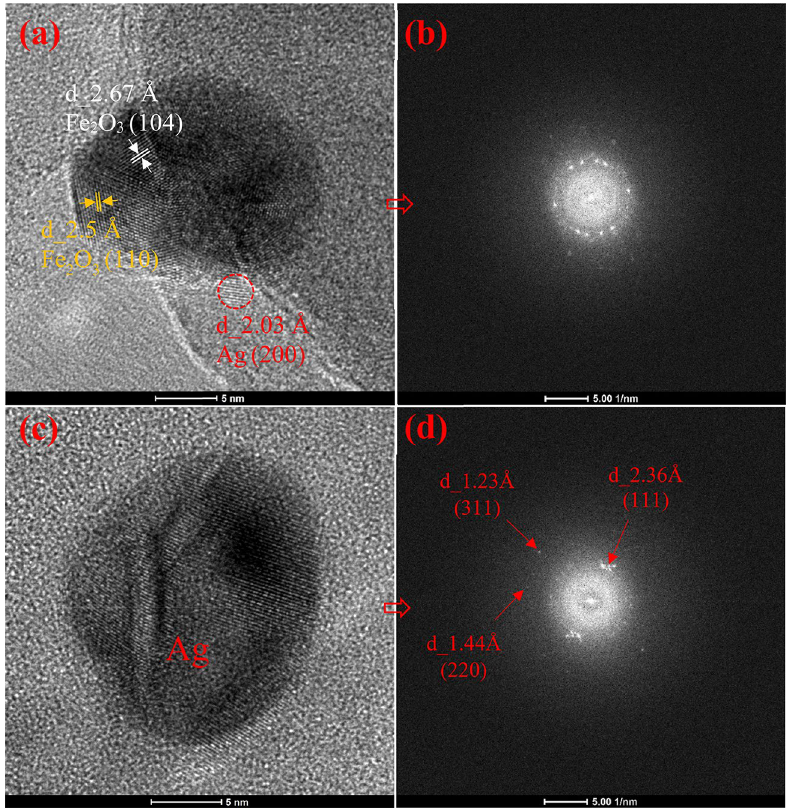
Figure 7. HRTEM images ( a and c ) and their corresponding FFT ( b and d ) of Fe 2 O 3 and Ag nanoparticles, respectively. The corresponding d-spacing of Ag and Fe 2 O 3 nanocrystals are